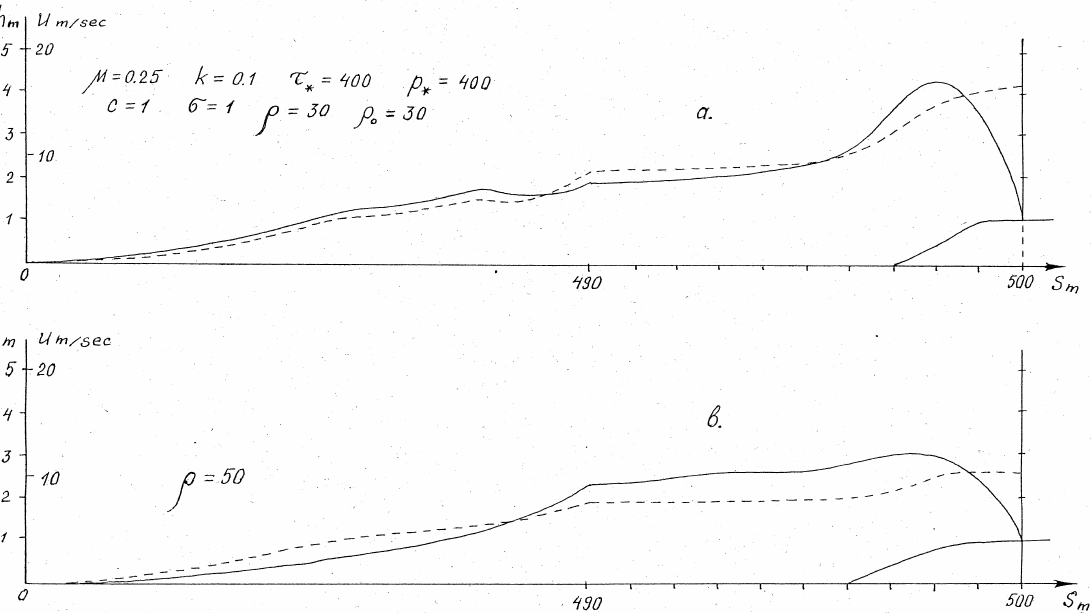
Figure 8. Examples of simulations with the full model, showing the distributions of new-snow depth and flow depth (full lines), and velocity (dashed lines) when the avalanche front reaches S f = 500m. Here, and in Figures 9 and S2.10–S2.14, the scale of the abscissa ( S ) is the same as for h and δ in the 10 m right behind the avalanche front, but strongly compressed for 0m < S < 490m. ( a ) Simulation with basic parameter set (no. 1 in Table 3). ( b ) Same as ( a ), except for the flow density increased from 300 to 500kgm − 3 (case 2 in Table